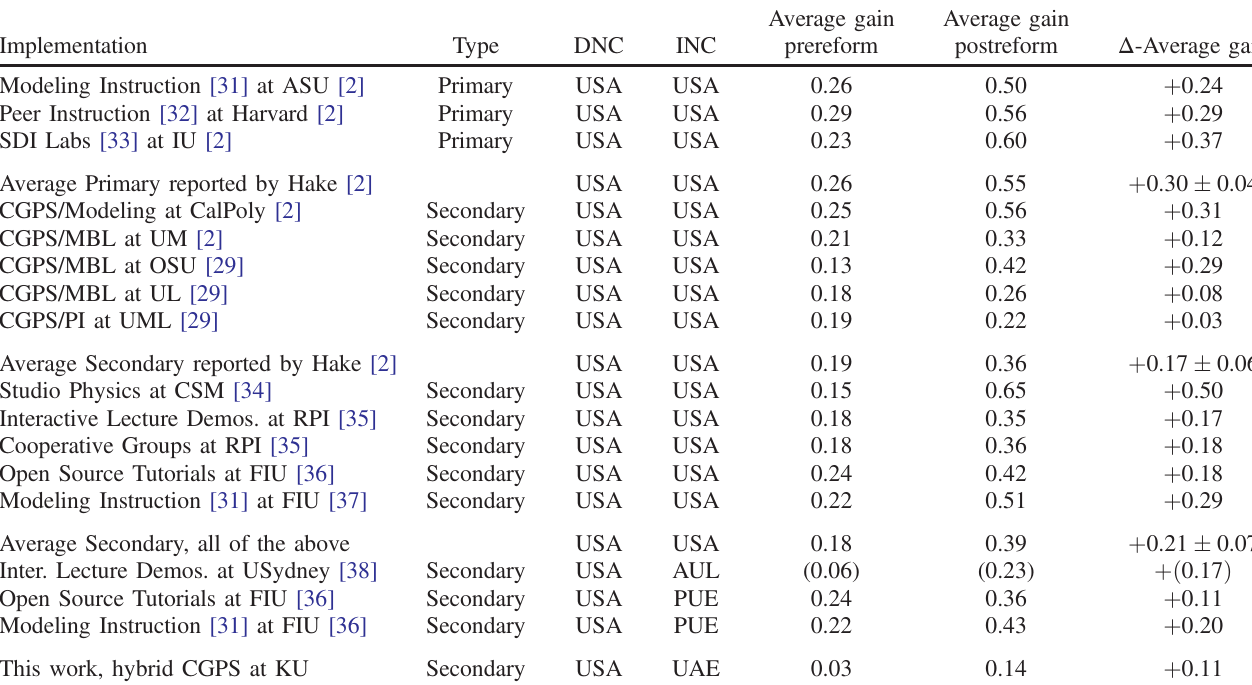
a FCME scores are scaled to FCI for comparison